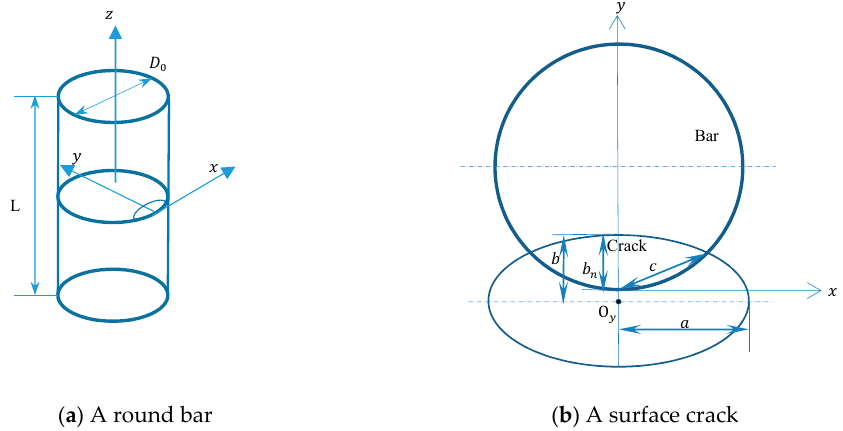
Figure 1. Definition of the geometrical parameters for a surface crack in a round bar.